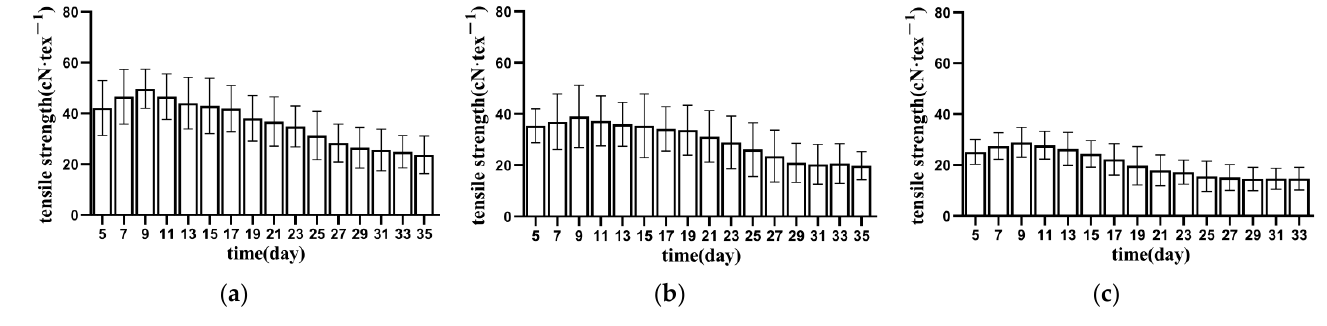
Figure 5. Tensile strength of lower banana stem fibres. ( a ) C Ⅰ ; ( b ) C Ⅱ ; ( c ) C Ⅲ .